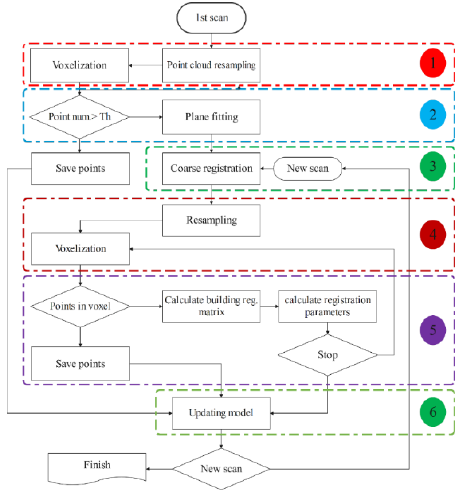
Figure 1. The overall flowchart of the proposed